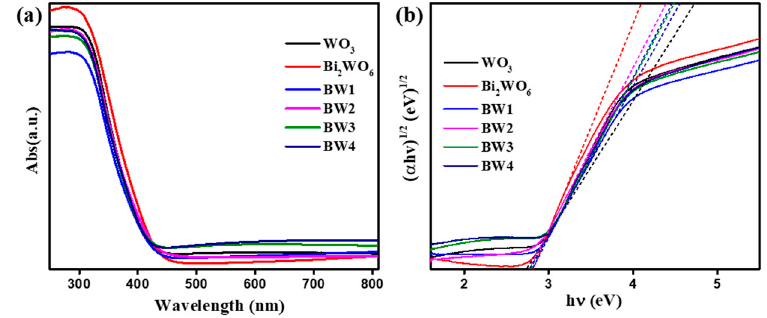
Figure 7. UV-vis diffused reflection spectra ( a ) and Tauc’s plots ( b ) of pure WO 3 , Bi 2 WO 6 , and Bi 2 WO 6 /WO 3 samples.